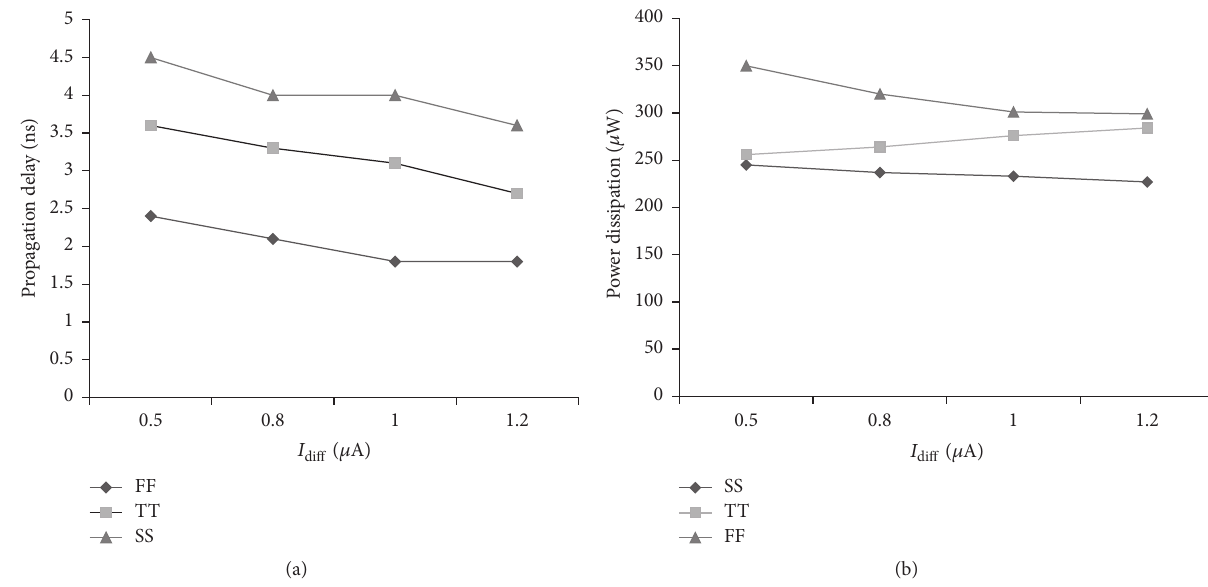
Figure 6: Effect of process corner variation on (a) delay and (b) power dissipation.